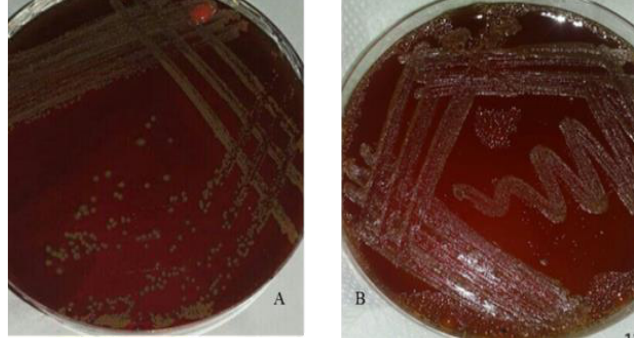
Figure 2 . NTM on Blood agar: (A) M. fortuitum, slightly beige and small in diameter colonies; (B) M. bonickei, white to slightly beige, small and translucent colonies